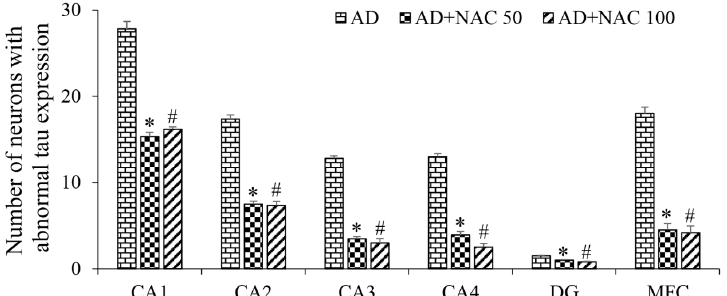
Figure 6. Quantitative estimation of neurofibrillary tangles (tau positive neurons) in the sub-regions of the hippocampus and prefrontal cortex. In CA1, CA2, CA3. & CA4 regions, a length of 300 µm was selected for quantification; in dentate gyrus (DG) and Media prefrontal cortex (MFC), a 300 µ 2 area was selected. Note that in all regions, the number of tau positive neurons significantly decreased in AD + NAC treated groups compared to AD group. Values are expressed as mean ± SE. AD vs. AD + NAC 50: *, p < 0.001; AD vs. AD + NAC 100: #, p < 0.001 (One-way ANOVA, Bonferroni’s multiple comparison test, n = 6 in all groups).